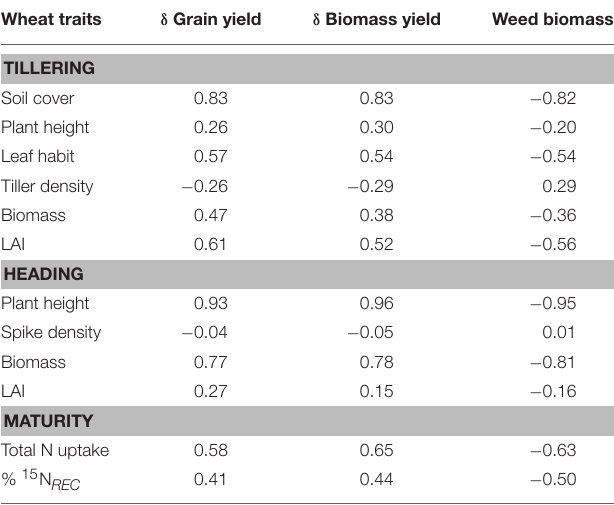
TABLE 6 | Simple correlation coefficients among traits measured in wheat genotypes grown in the absence of interspecific competition at tillering, heading, and plant maturity; differences ( δ ) between weed-free and weedy crops in grain and biomass yield; and weed biomass ( N = 12 ). Wheat